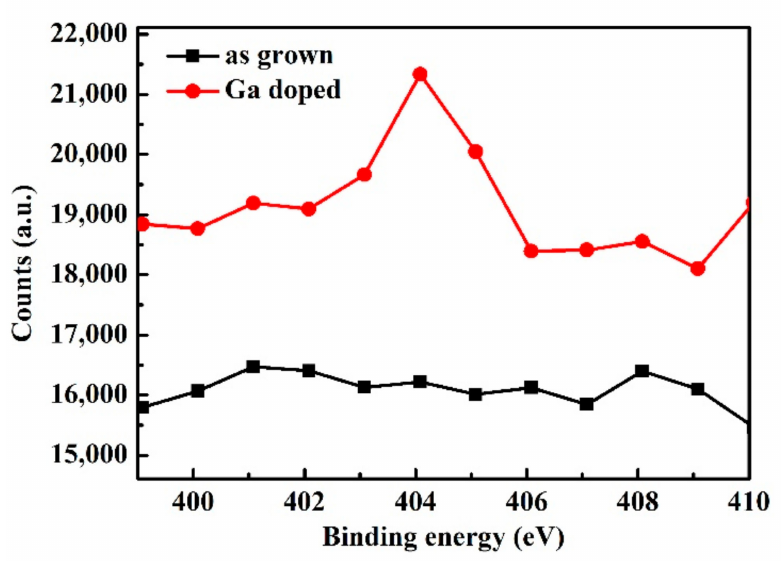
Figure 10. XPS survey spectrum of the ZnMgO